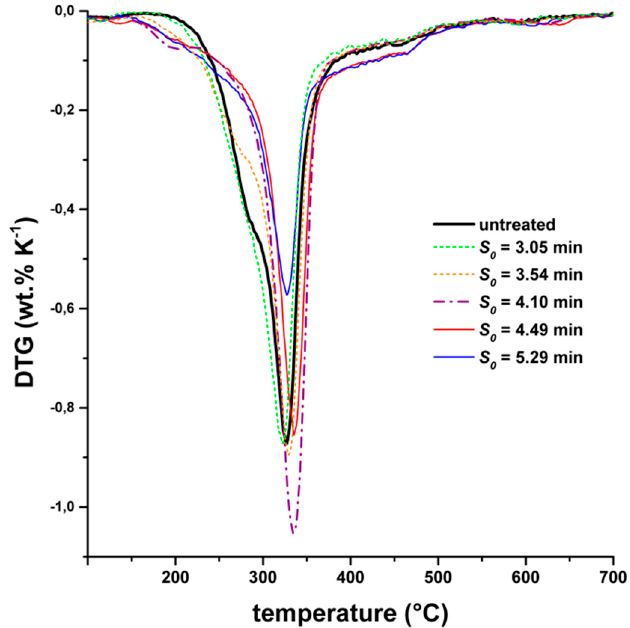
Figure 4. Differential thermogravimetric analysis (DTG) of untreated and pretreated rice straw depending on the severity parameter S 0 of the steam explosion.